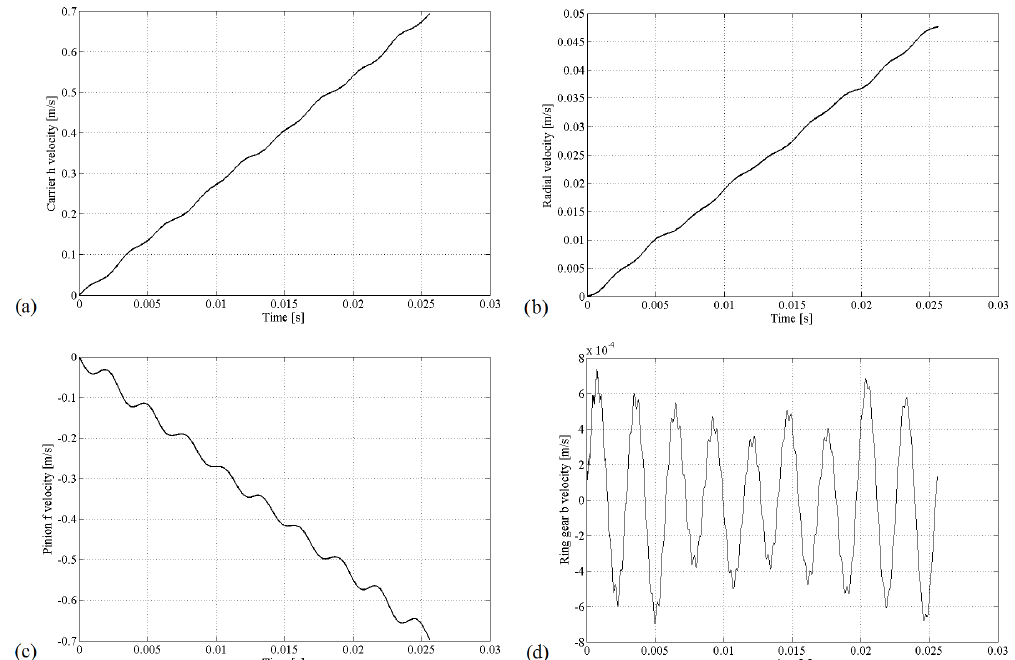
Figure 5. Velocity diagrams for c 1 = 1 . 67 × 10 10 Nm − 1 , c 2 = 1 . 56 × 10 10 Nm − 1 , k 1 = 3200Nsm − 1 , and k 2 = 2400Nsm − 1 : (a) y 1 direction, (b) θ h direction, (c) θ f direction, and (d) θ b direction.